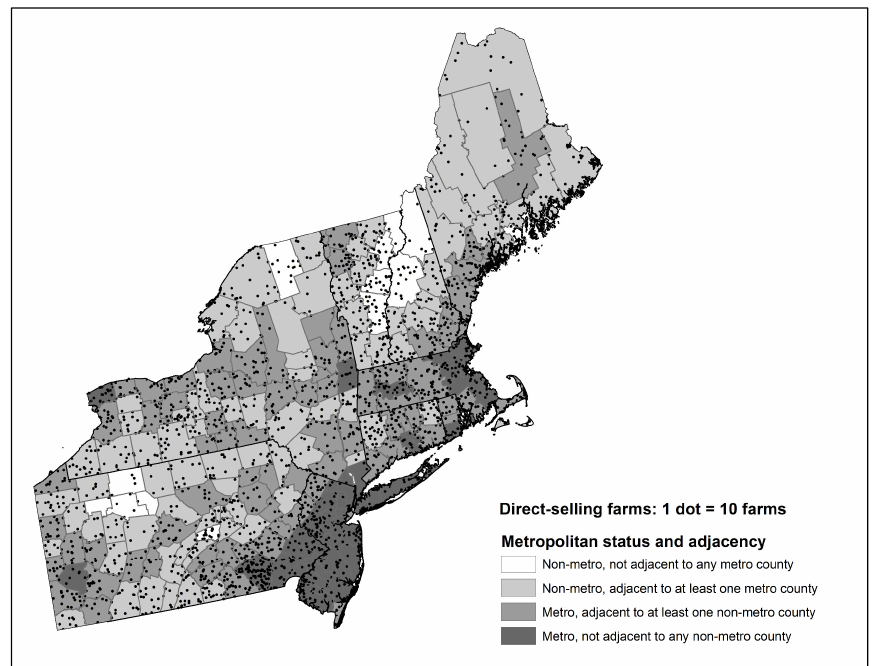
Figure 1. Number of Direct-selling Farms and Metropolitan Adjacency